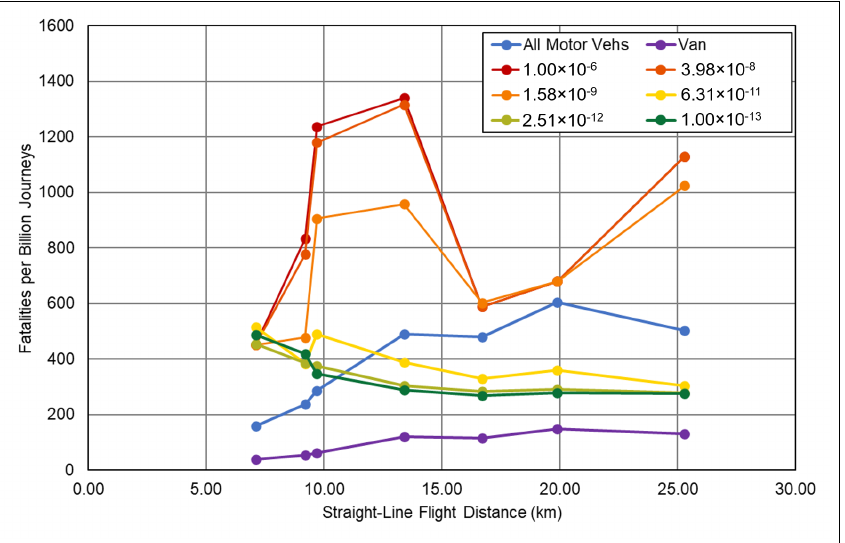
Figure 6. Comparison of fatality rates per billion journeys, relative to origin-destination straight-line flight distance and risk algorithm threshold. Peaks seen in the higher risk threshold plots correlate with urban